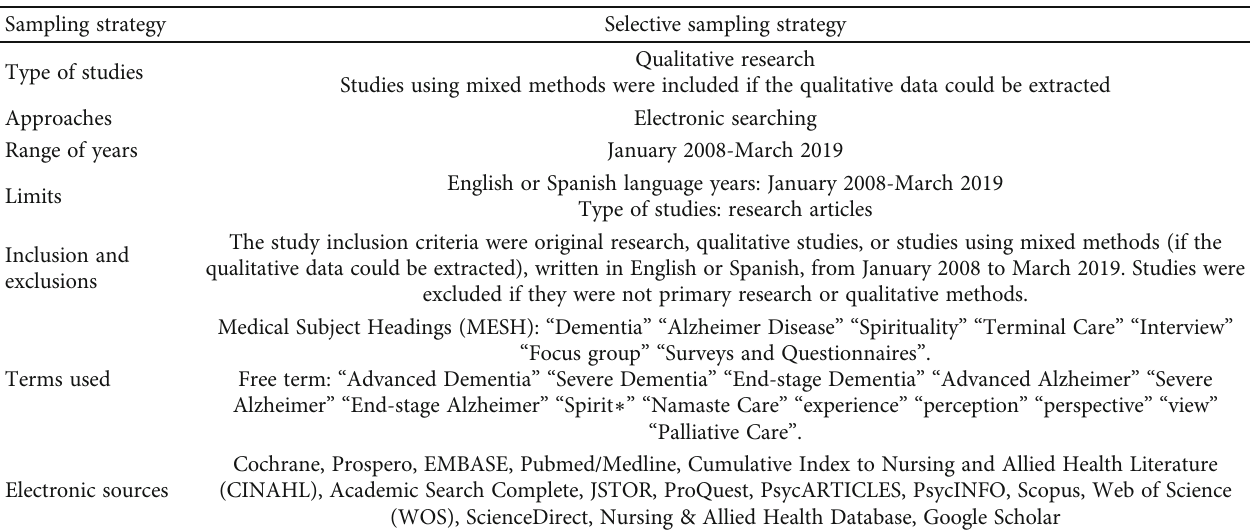
Table 1: STARLITE proposal